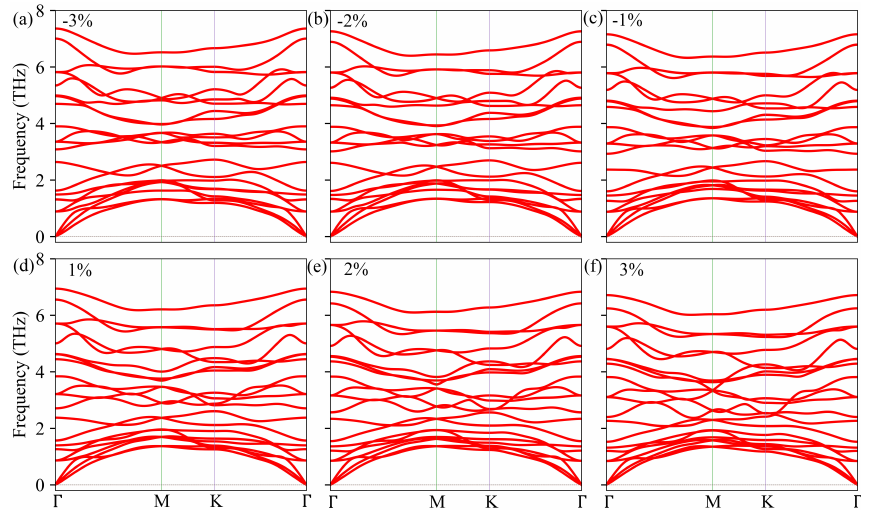
Figure 8. Phonon spectrum curves of Pb Bi 2 Te 2 S 2 monolayer under − 3% ( a ), − 2% ( b ) and − 1% ( c ) compressive strains, and 1% ( d ), 2% ( e ) and 3% ( f ) tensile strains.